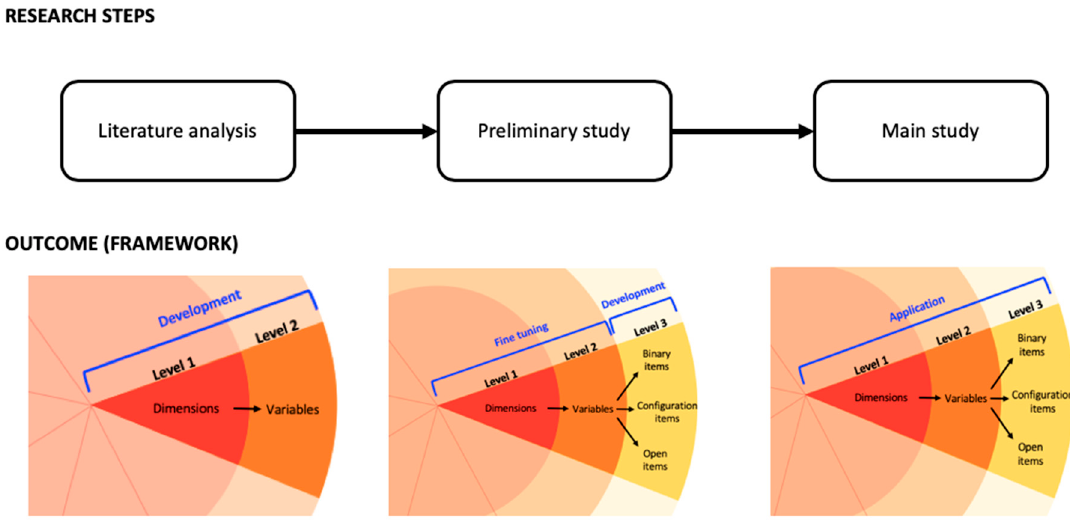
Figure 1. Platform descriptive framework.